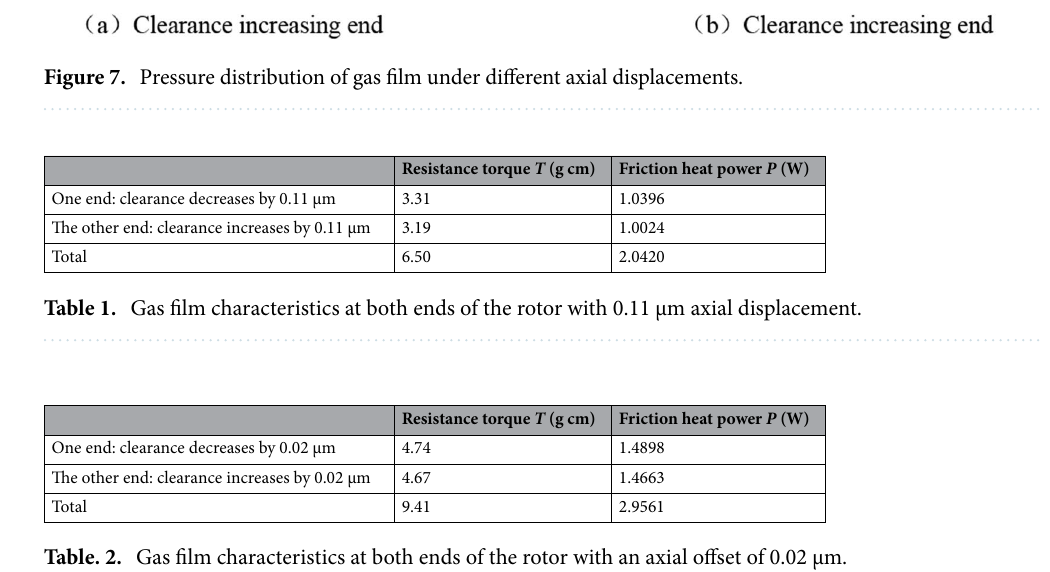
Table. 2. Gas film characteristics at both ends of the rotor with an axial offset of 0.02